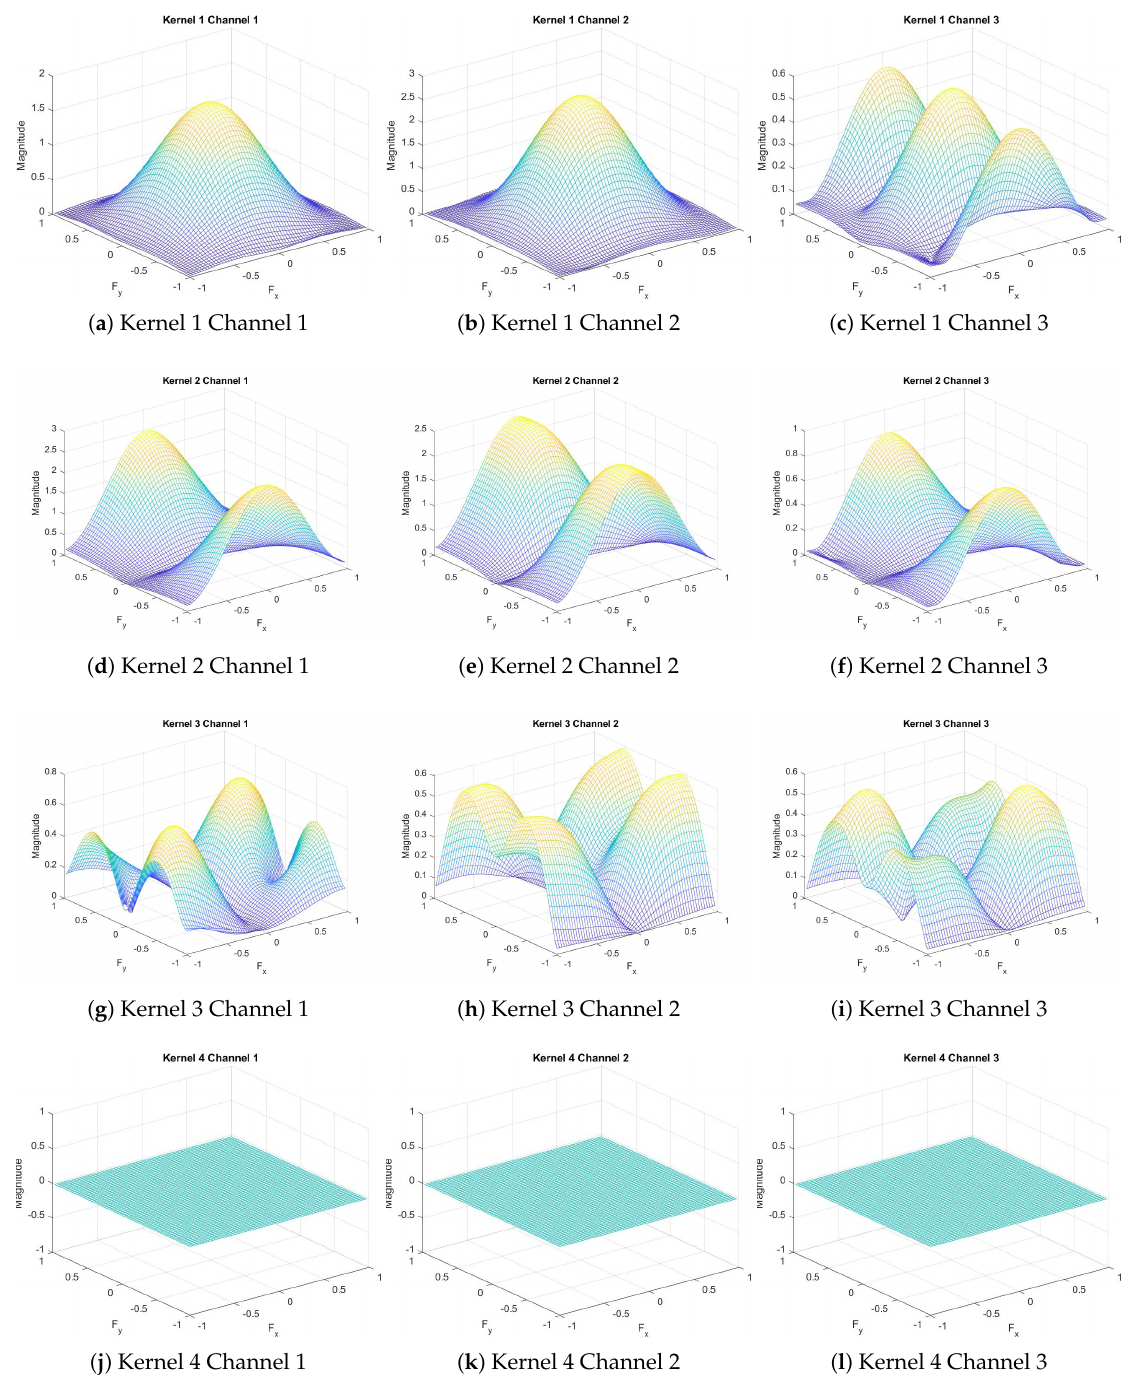
Figure 3. Frequency response of the first convolutional